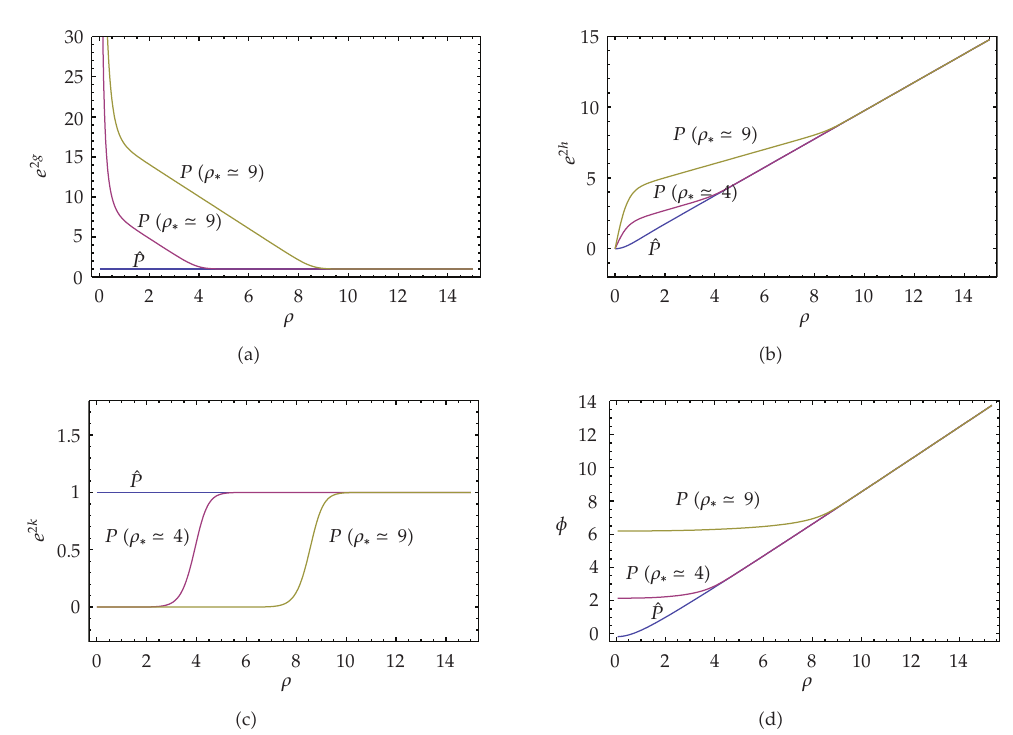
Figure 10: The functions (cid:5) e 2 g ,e 2 h ,e 2 k , Φ(cid:6) appearing in the metric for the same solutions as in Figure 9, computed rescaling P → P/N c and Q → Q/N c (cid:3) 58 (cid:4)